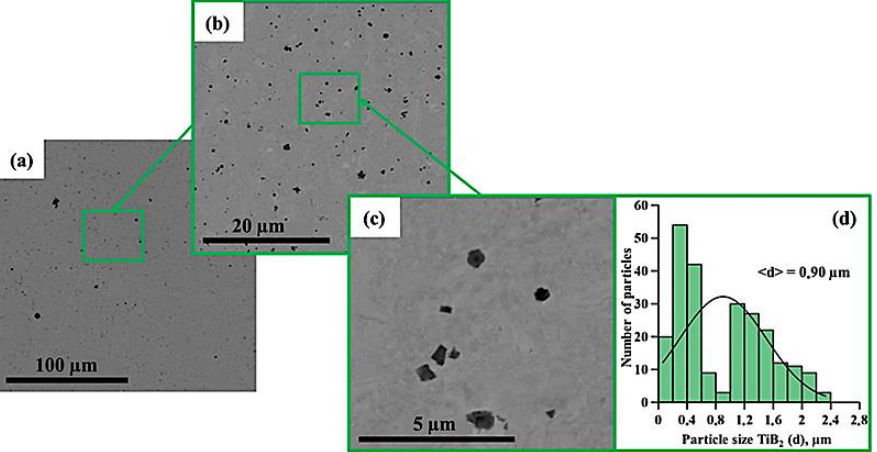
Figure 6. SEM image of the structure of a composite fabricated by direct laser deposition from the Inconel 625 + 10 wt% NiTi – TiB 2 powder mixture ( a – c ), histogram of the distribution of ceramic inclusions by size ( d ).